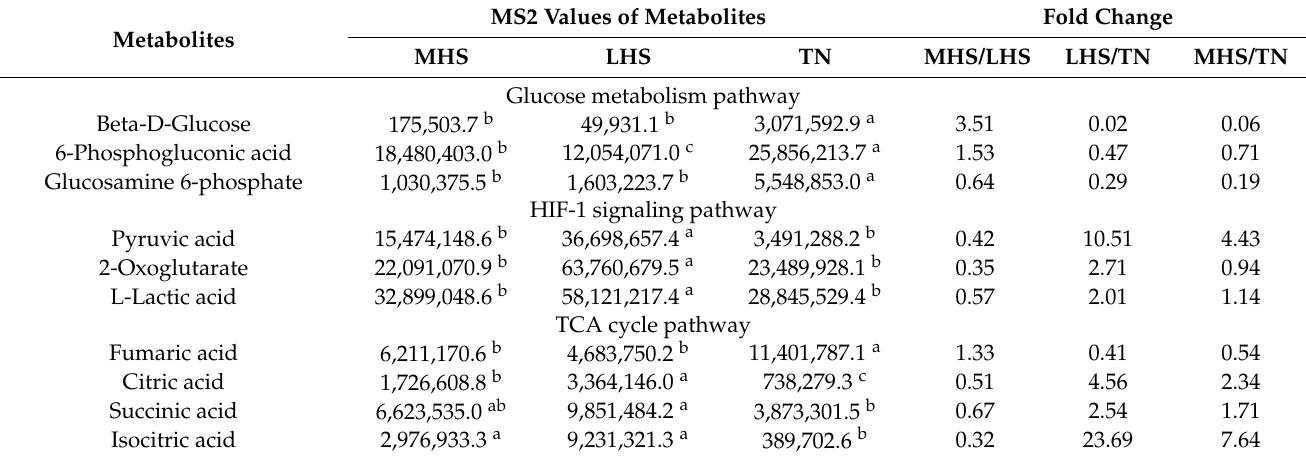
Table 3. Distinct plasma metabolites from three carbohydrate metabolism pathways. Metabolites